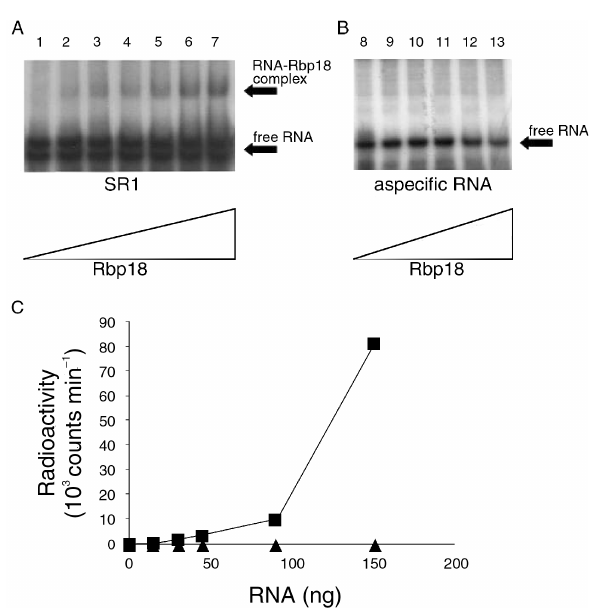
Figure 5. Rbp18 interacts specifically with C/D box sRNAs. (A) elec- trophoretic mobility shift assay showing the interaction of increasing amounts of recombinant Rbp18 (0, 50, 80, 100, 150, 200, 250 pmol; Lanes 1–7) with 50 pmol of sR1. (B) 50 pmol of a nonspecific oligonucleotide having length and composition similar to sR1 were incubated with increasing amounts of recombinant Rbp18 (50, 80, 100, 200, 250 pmol; Lanes 8–13). (C) Increasing amounts of sR1 ( (cid:2) ) or a nonspecific oligonucleotide ( (cid:3) ) labeled in vitro with [ 32 P]UTP were mixed to the Ni-NTA resin pre-bound to the recombinant Rbp18 and pretreated with Torula yeast RNA to saturate nonspecific RNA binding sites. After extensive washing, the radioactivity reatained by the resin was measured by liquid scintillation